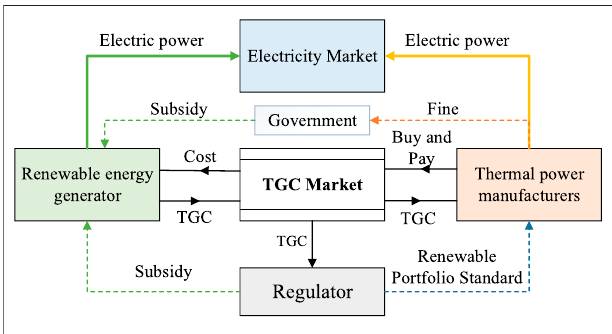
FIGURE 7 | Operation process of TGC trading